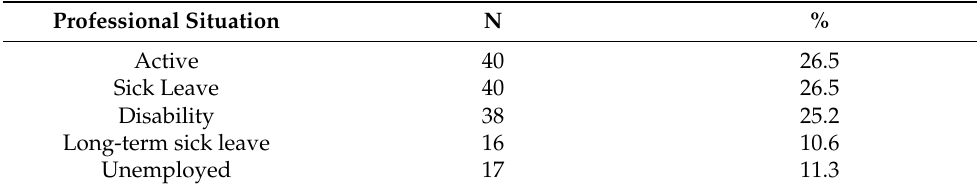
Table 1. Professional Status of patients in the PREDIBACK